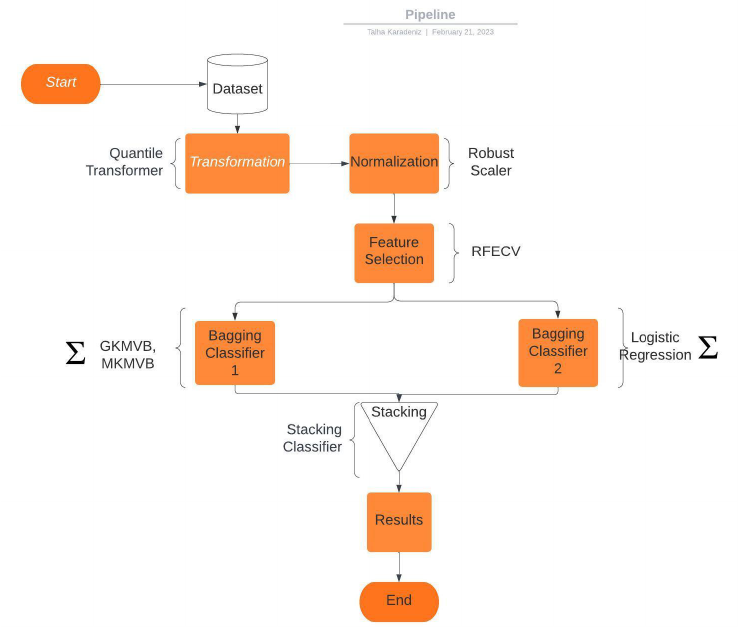
Figure 1. Prediction